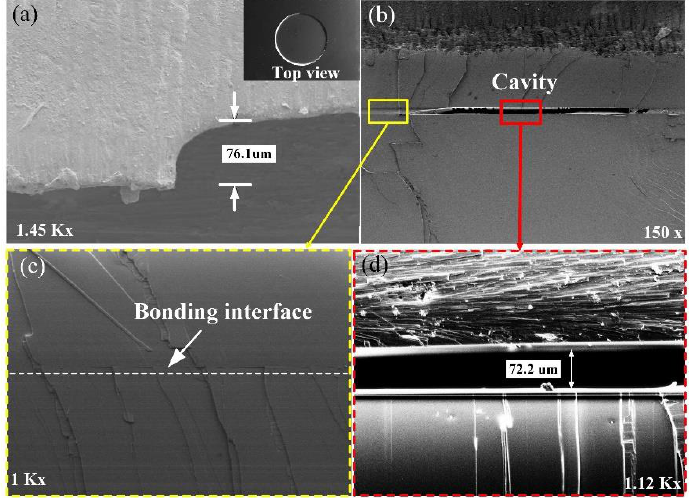
Figure 3. ( a ) The cross-selection SEM image of the cavity. ( b – d ) SEM images of the bonding interface and cavity at different magnifications.